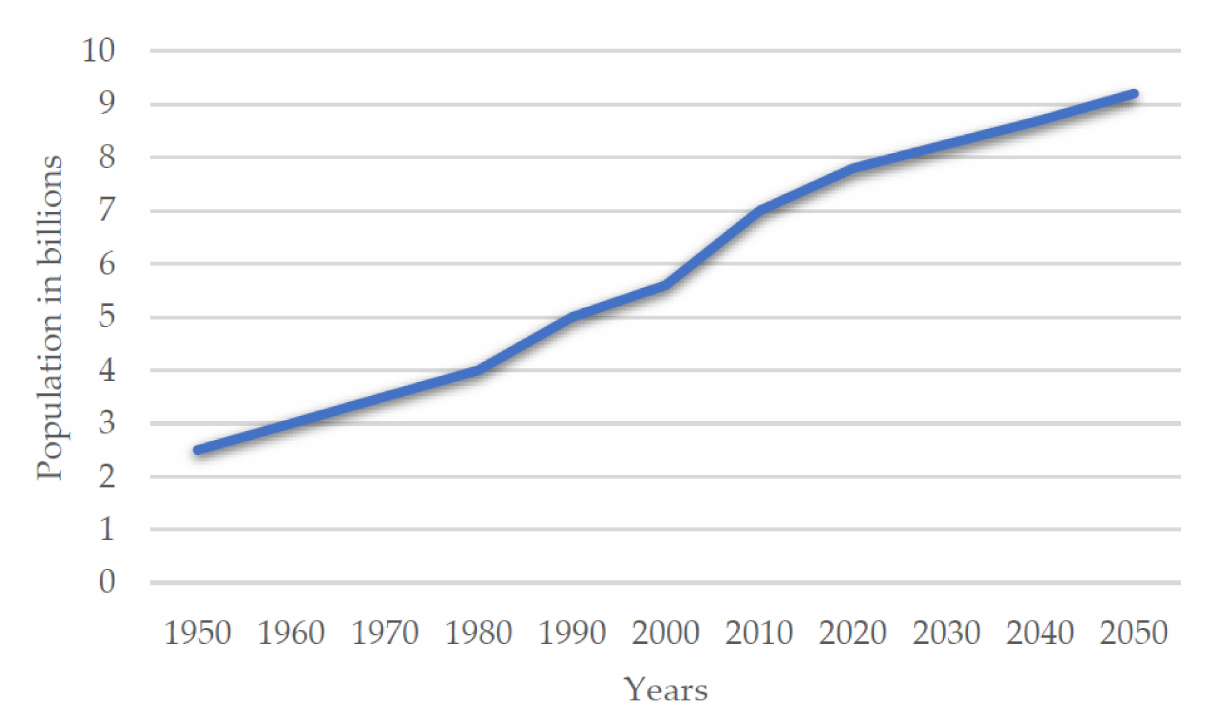
Figure 1. World population growth 1950–2019 with projections to 2050 based on Jensen et al., 2020